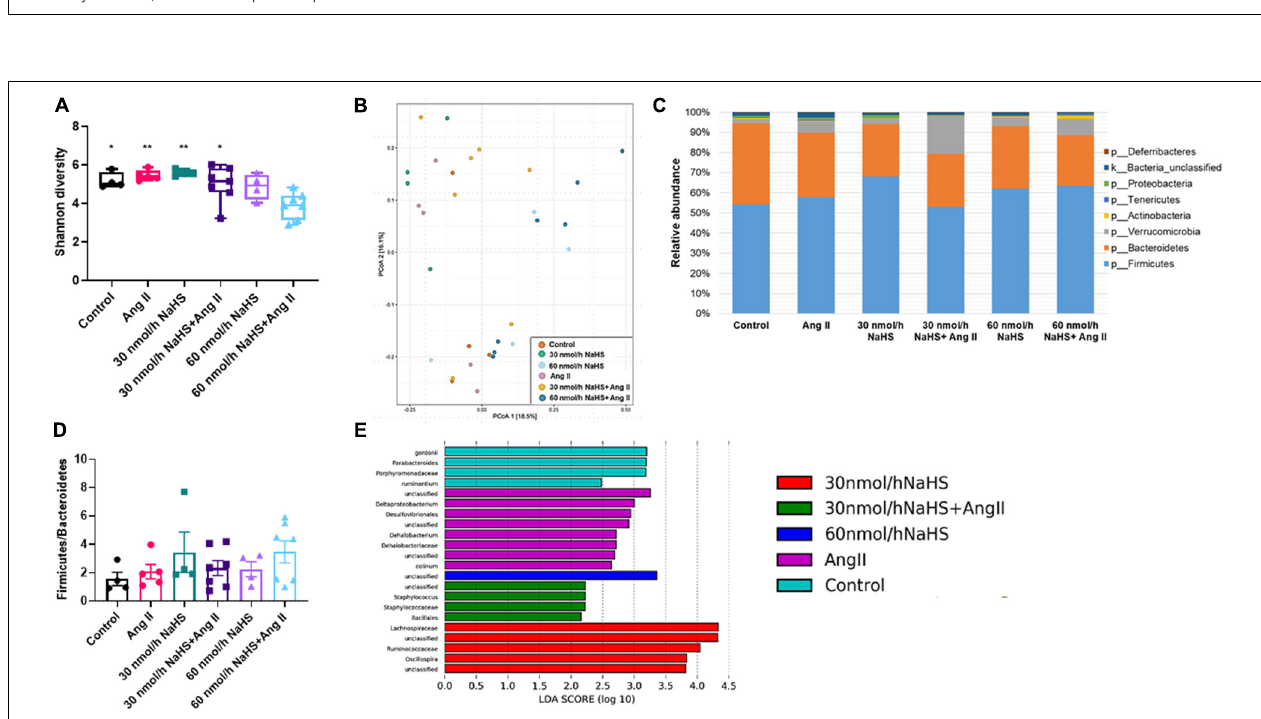
FIGURE 4 | Alterations in cecal microbial composition of Sprague–Dawley rats with angiotensin (Ang) II hypertension and after intracerebroventricular NaHS administration. (A) Gut bacterial alpha diversity (Shannon index). Data were analyzed by one-way ANOVA, Tukey’s multiple comparisons test, and presented as minimum to maximum with a median. * p < 0.05, ** p < 0.01 vs. 60 nmol/h NaHS/Ang II. (B) Gut bacterial beta diversity (principal coordinate analysis, PCoA) determined by permutational analysis of variance (adonis R function or PERMANOVA). Operational taxonomical unit (OTU) abundance is summarized into Bray–Curtis dissimilarities and performed a PCoA ordination. (C) Mean relative abundance of gut bacterial phyla identified in cecal samples in each experimental group. (D) Ratio of Firmicutes to Bacteroidetes . Data were analyzed by one-way ANOVA followed by Kruskal–Wallis test and presented as mean ± SEM. (E) Linear discriminant analysis effect size (LEfSe) analysis showing enriched taxa in each group. Control ( n = 4), Ang II ( n = 5), NaHS ( n = 4), and NaHS/Ang II-treated rats ( n = 7).